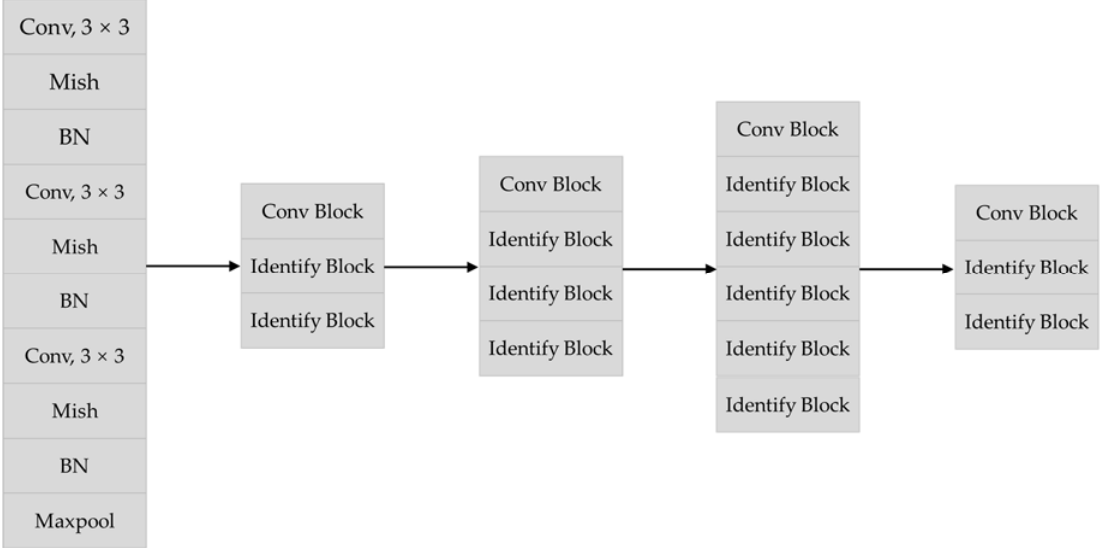
Figure 7. Diagram of the backbone of feature extraction module, i.e., adaptation ResNet ‐ 50. Conv, 3 × 3 stands for a convolutional operation with 3 × 3 kernel; BN stands for 2D batch normalization, Mish refers to Mish activation function. Maxpool means maximum pooling with kernel size of 2. Conv Blocks and Identify Blocks used in original ResNet ‐ 50 were adapted in the proposed model.